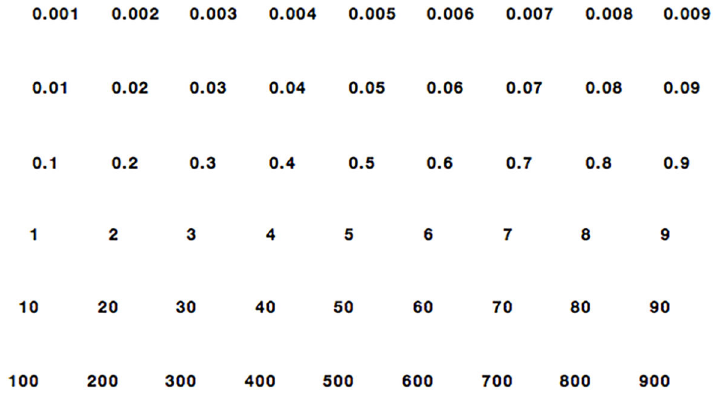
Figure 3. An example of a Tens